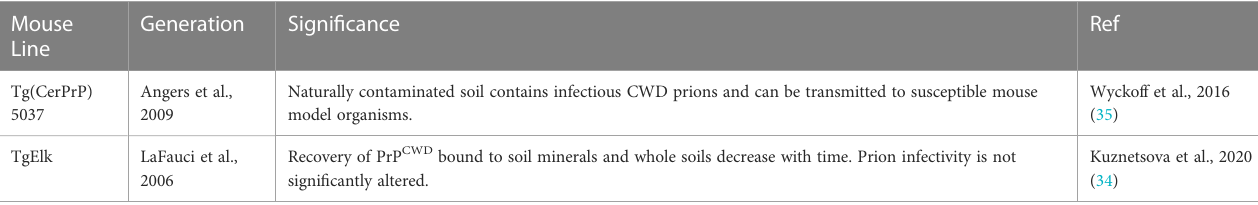
TABLE 8 Transmission through environmental